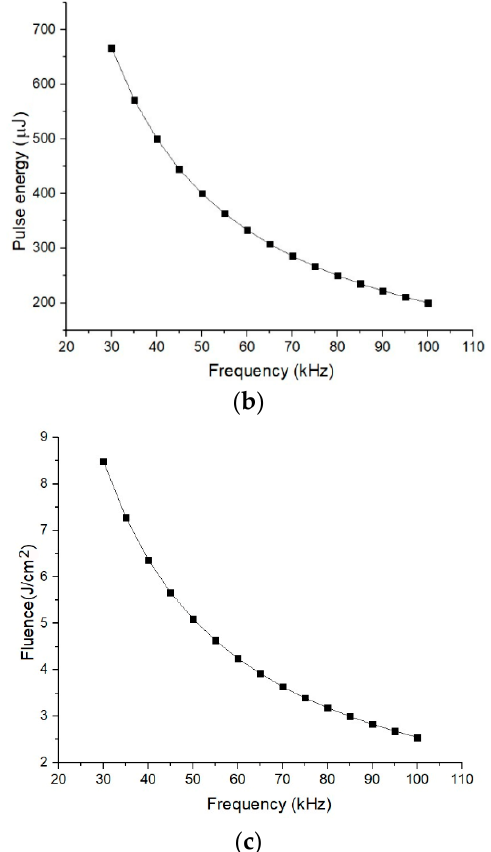
Figure 6. Pulse width ( a ), pulse energy ( b ) fluence ( c ) engendered by frequency. The spots number per cm 2 are represented in Figure 7, by speed and hatch axis direction. The speed direction is the direction of direct laser texturing, and the hatch direction is the distance between the center to center of the pattern shape applied. Figure 7 outlines that there are more spots created on the velocity direction than the hatch direction, meaning that speed influences the roughness and the number of spots per cm 2 . The spots number can be a decisive factor in defining the necessary resolution for the desired purpose in micro texturing. The number of spots on the hatch direction is constant, different for each kind of pattern. For the speed direction, the number of spots is decreasing while the speed increases.